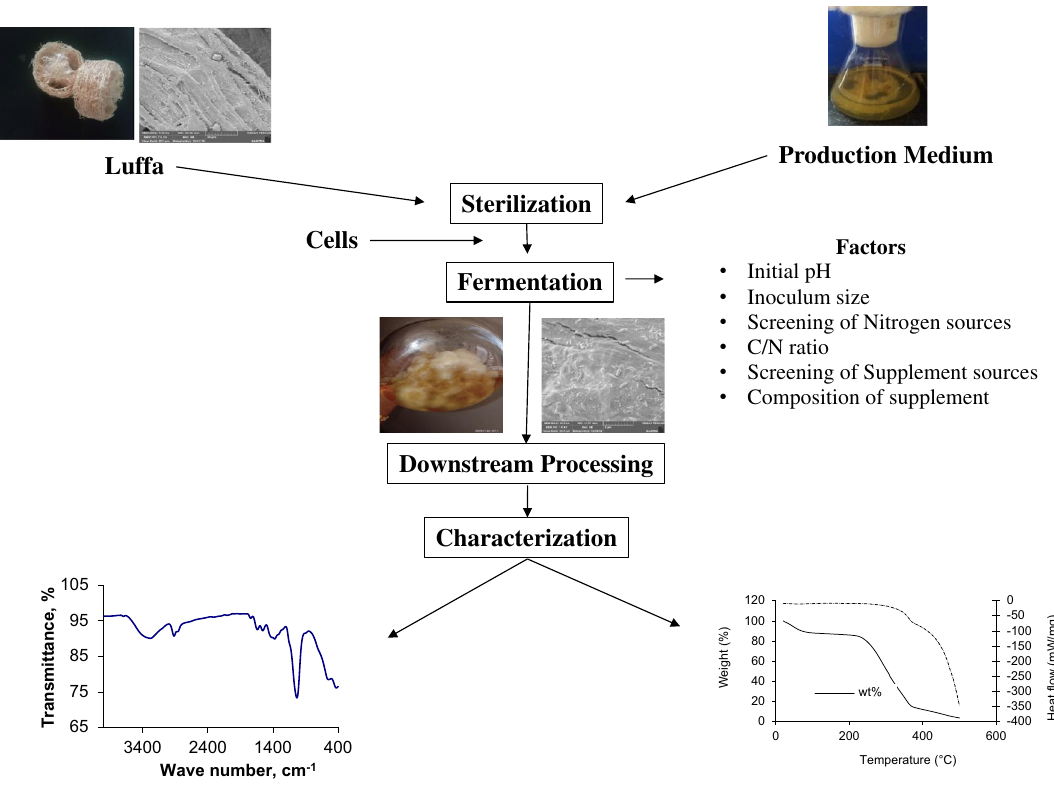
Figure 1. Schematic diagram for the production of BC using immobilized Gluconacetobacter kombuchae on